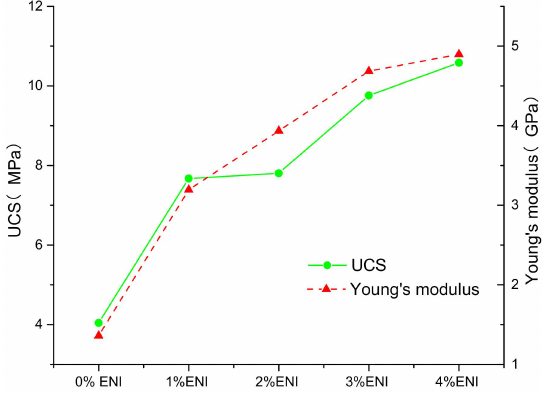
Figure 3. Shale uniaxial compression test